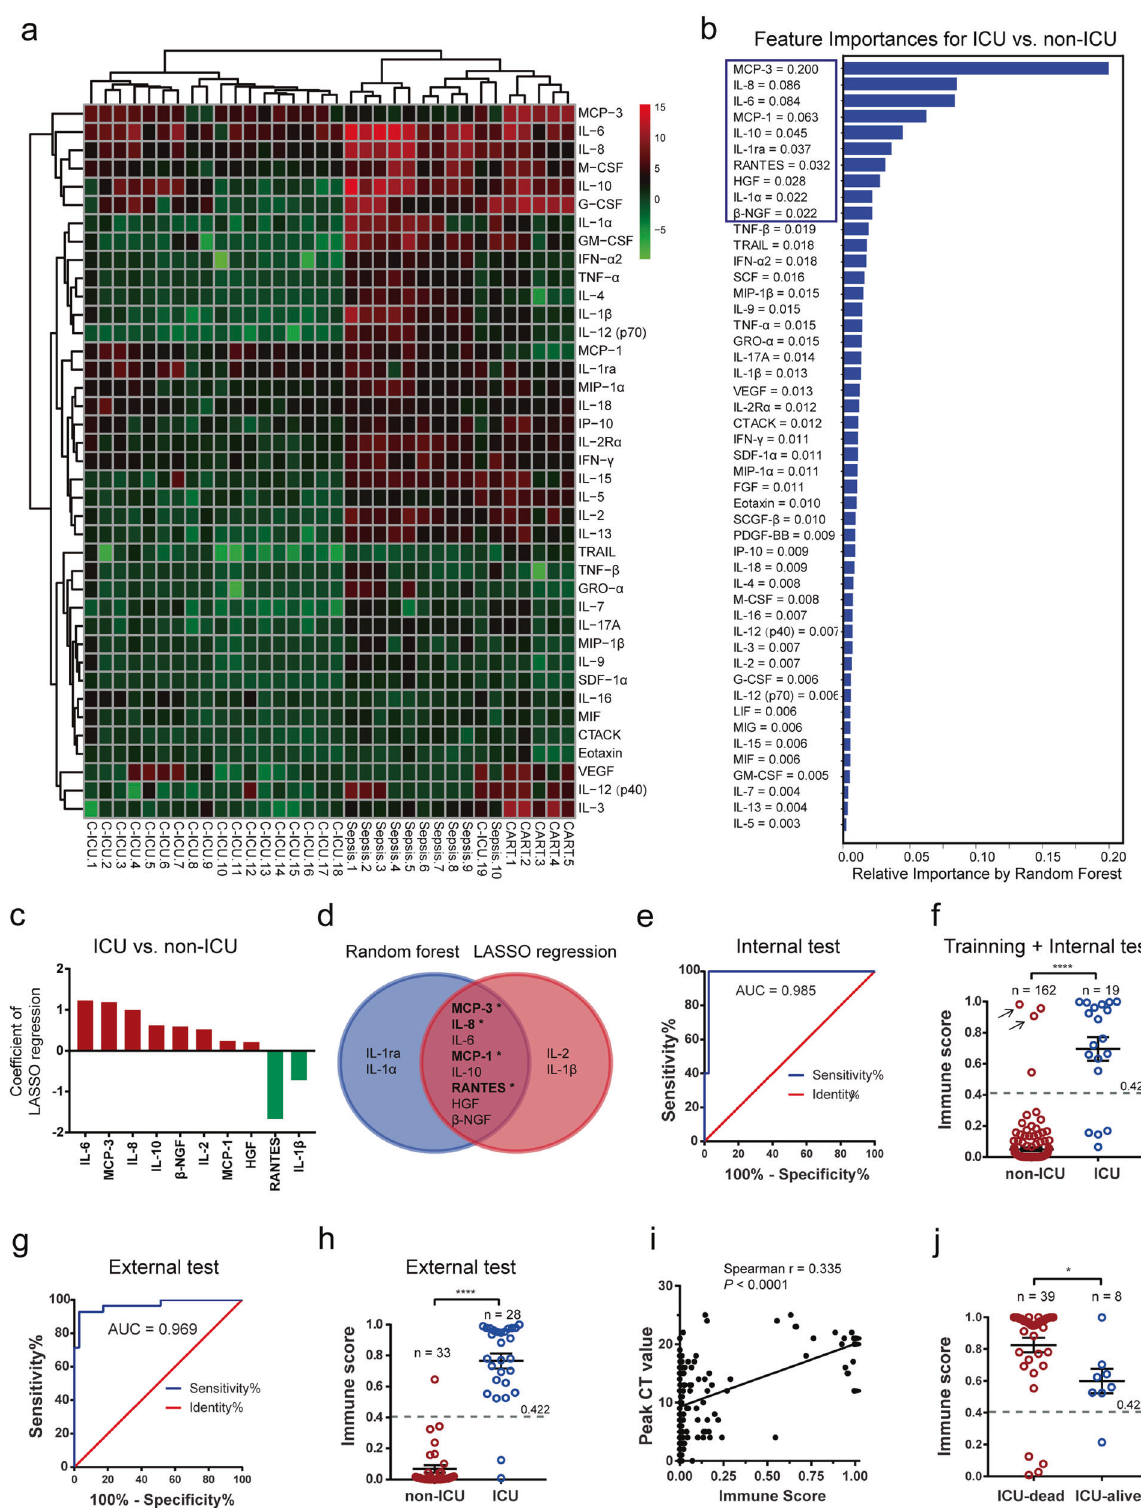
versus 1%, P < 0.0001) in high-scoring subgroup might mirror higher morbidity rate of ARDS or multiple organ failure in this subgroup, and also suggesting these treatments might not interfere the computation of MCP-3/IL-8 algorithm. Furthermore, the degree of organic impairment, as evaluated by the MCP Signal Transduction and Targeted Therapy (2020)